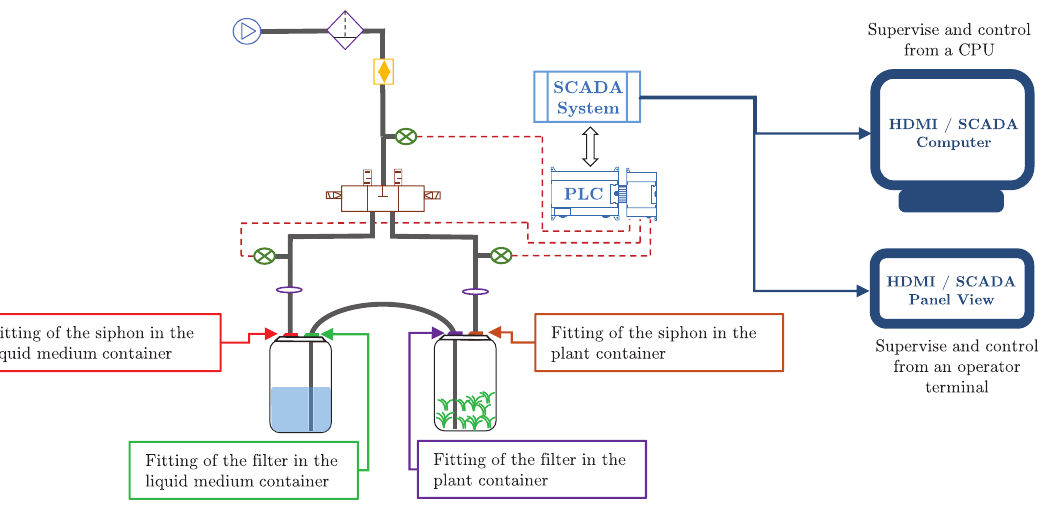
Figure 4. The new failures that we propose to detect in the TIBs. SCADA refers to Supervisory Control And Data Acquisition; PLC refers to Programmable Logic Controller; and HDMI refers to High-Definition Multimedia Interface, which is used for communicating with the SCADA